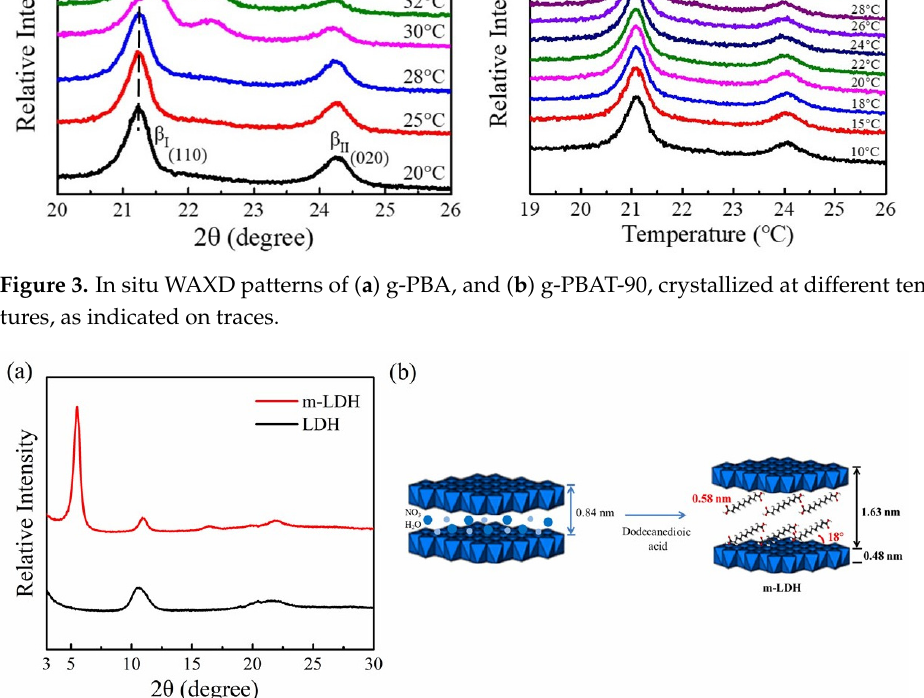
Figure 4. ( a ) X-ray diffraction patterns for LDH and m-LDH. ( b ) Schematic representation of the probable arrangement for dodecanedioic acid-modified LDH (m-LDH).